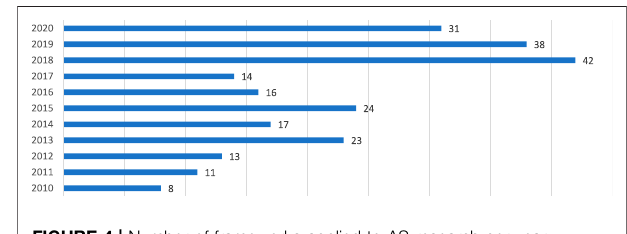
FIGURE 4 | Number of frameworks applied to AS research per year.